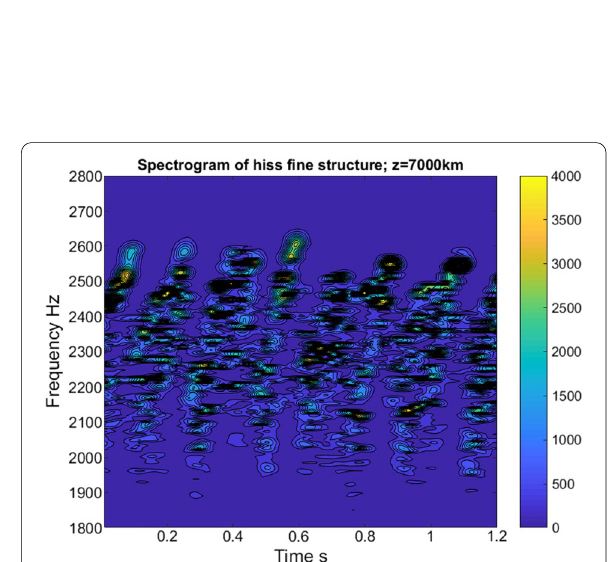
Fig. 8 Nonlinear wave particle interaction effects in a strong hiss band of RMS amplitude 27pT. This results in spectral structuring in the form of a riser sequence. Linear growth rate of 90db/s is too small for full emission